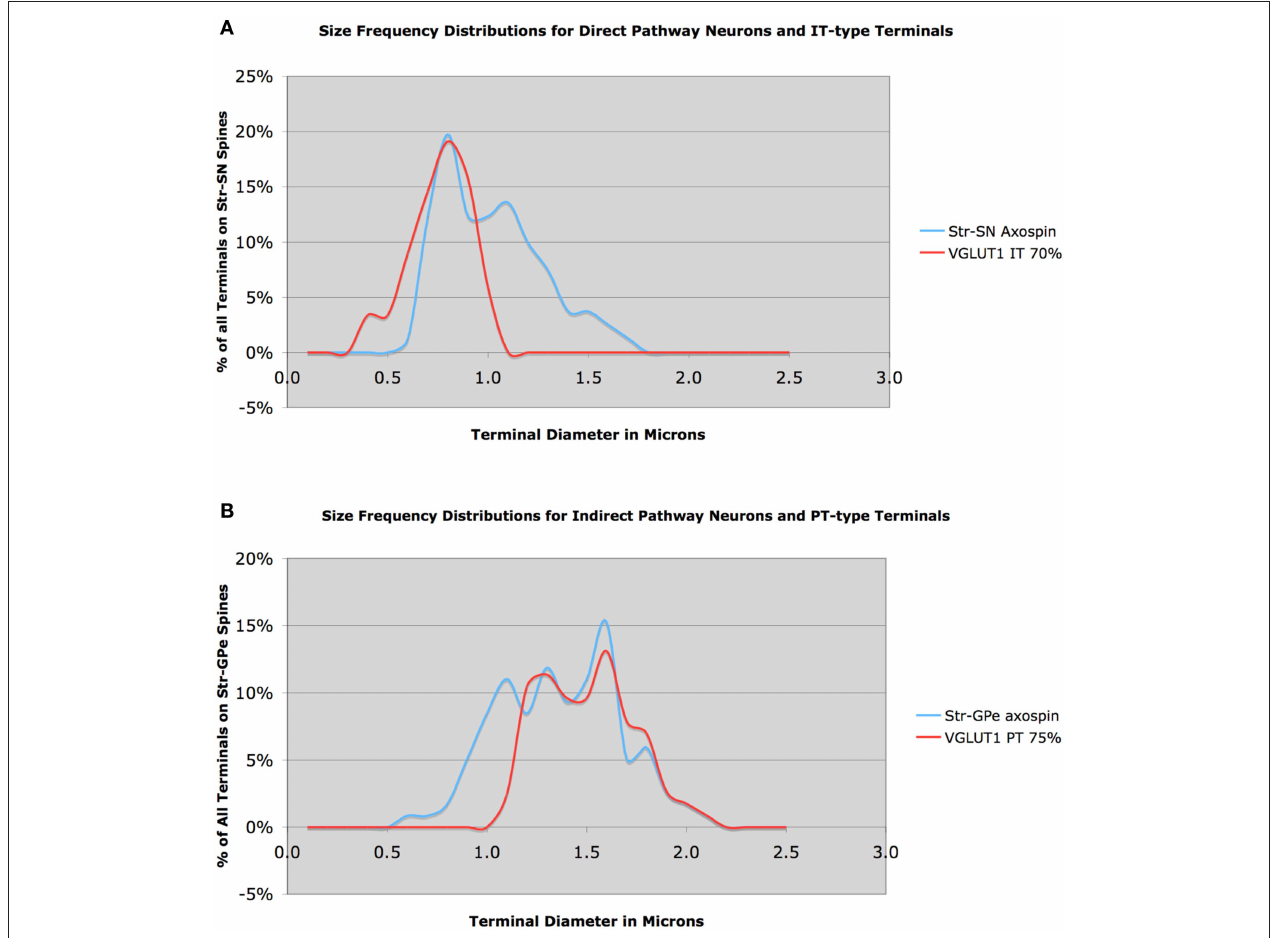
size distribution of IT-type terminals closely matches that of terminals on striato-SNr neurons, except for a peak at 1.1 μm. Similarly, note that the size distribution of axospinous PT-type terminals closely matches that of axospinous terminals on striato-GPe neurons, except for a peak at 1.1 μm. The peak